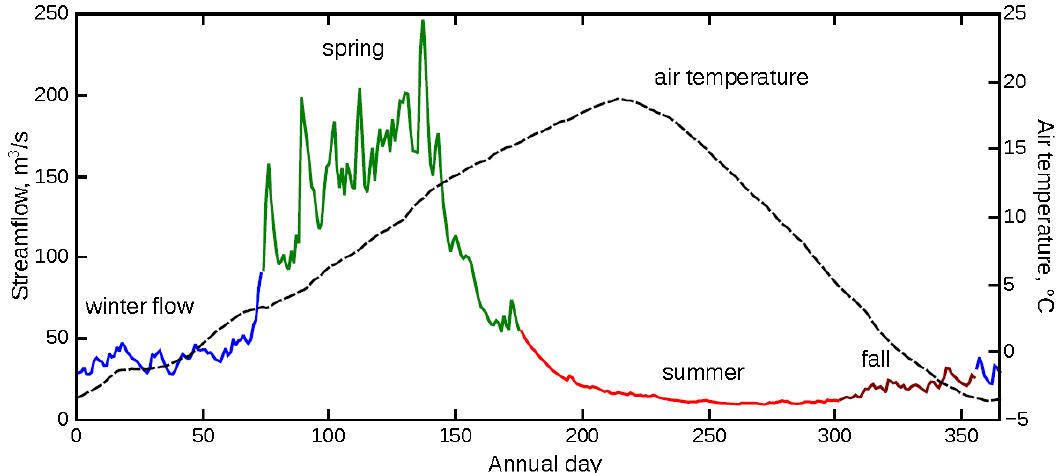
Figure 3. Median daily flow of the Coeur d’Alene River at Cataldo, Idaho, from 2005–2015 (courtesy of the U.S. Geological Survey) and median daily air temperature from 1981–2010 (courtesy of the Western Regional Climate Center). Seasonal indicators are identified according to changes in the hydrology of the river.